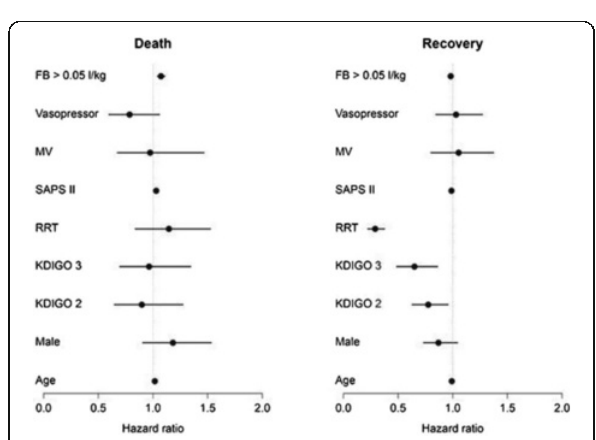
Fig. 38 (abstract A95). FB = fluid balance, MV = mechanical ventilation, RRT = renal replacement